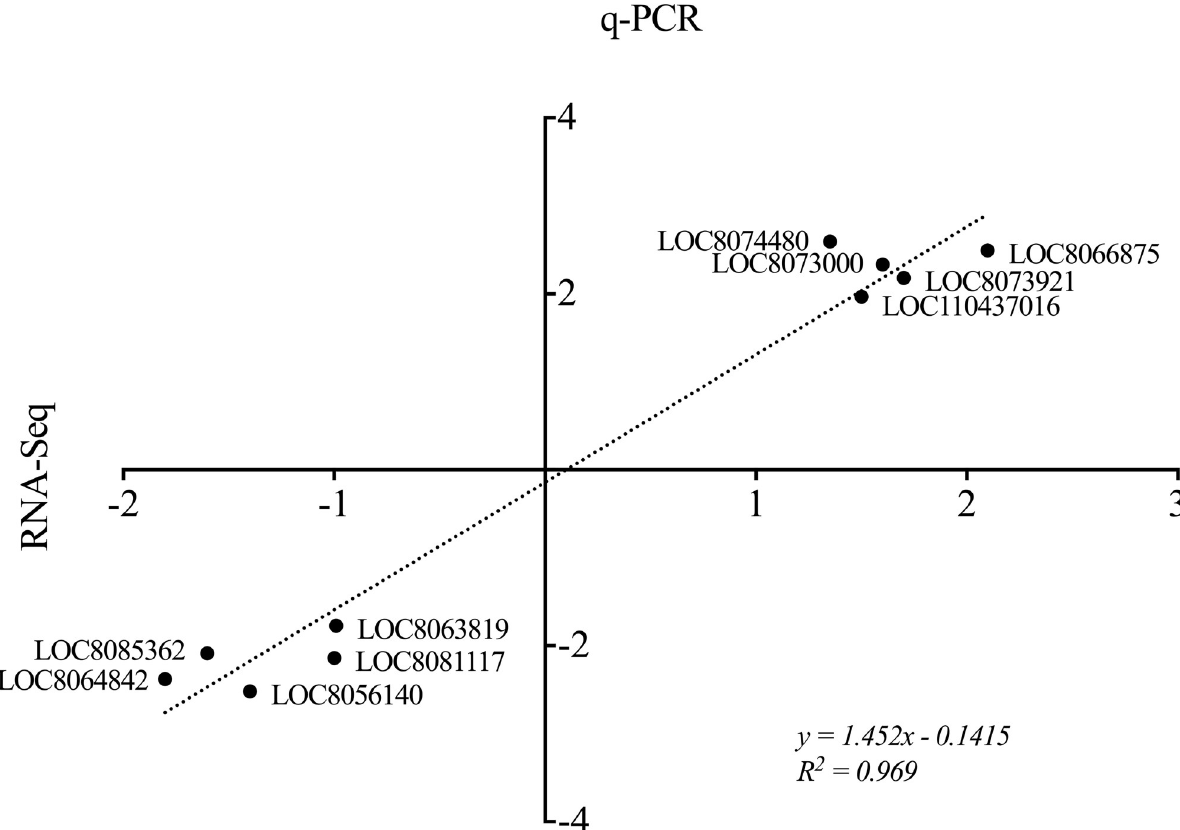
Fig 5. Validation of the expression profiles of 20 randomly chosen DEGs obtained from RNA-seq via quantitative PCR (q-PCR). Shown are the fold changes of the log 2 values resulting from RNA-seq, and the q-PCR results fit a linear regression ( y = 1 . 425x-0 . 1415 , R 2 = 0 . 969